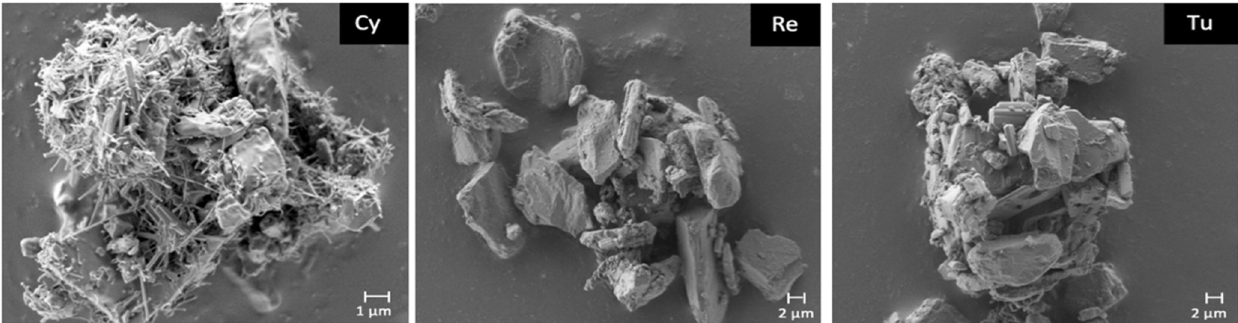
Figure 4. Scanning electron microscopy images of NCE-B blends obtained with Cyclomix high shear impact mixer (Cy), Resodyn Acoustic Mixer (Re) and Turbula (Tu) after aerosolisation (magnification × 20 K). Particles were retrieved in the respirable dose collector of the fast screening impactor.